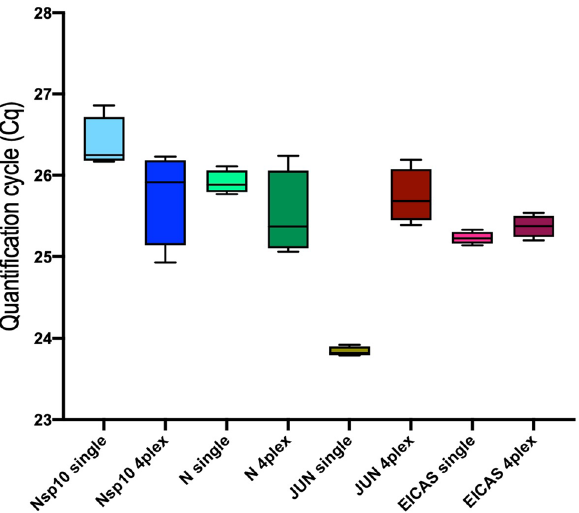
Figure 3. Comparison of Cqs obtained from single- and multiplex assays for the four panels making up CoV2-ID. The line through the box shows median Cqs and the whiskers denote minimum and maximum